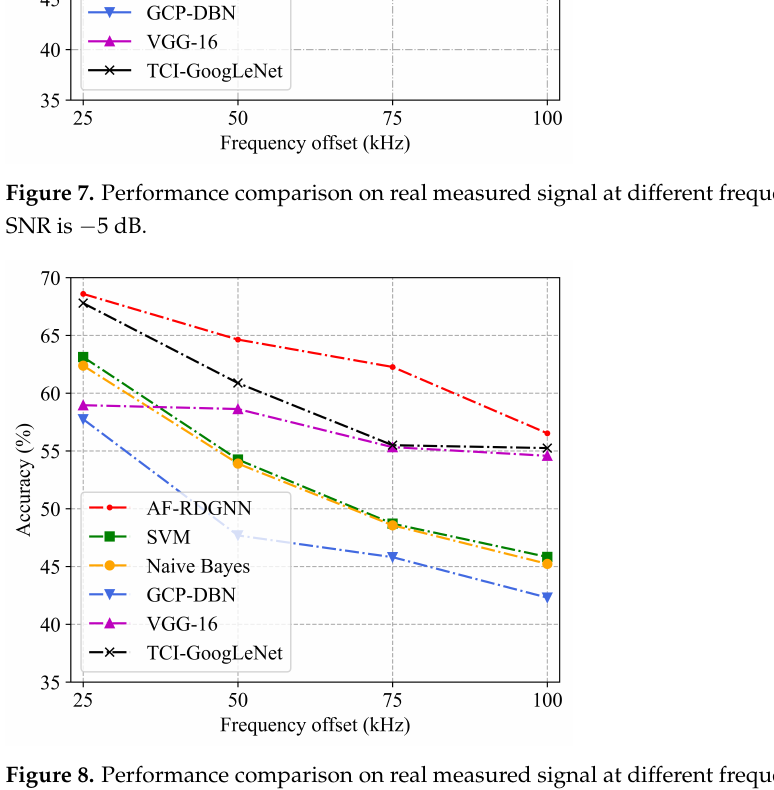
Figure 8. Performance comparison on real measured signal at different frequency offsets when the SNR is − 10 dB.